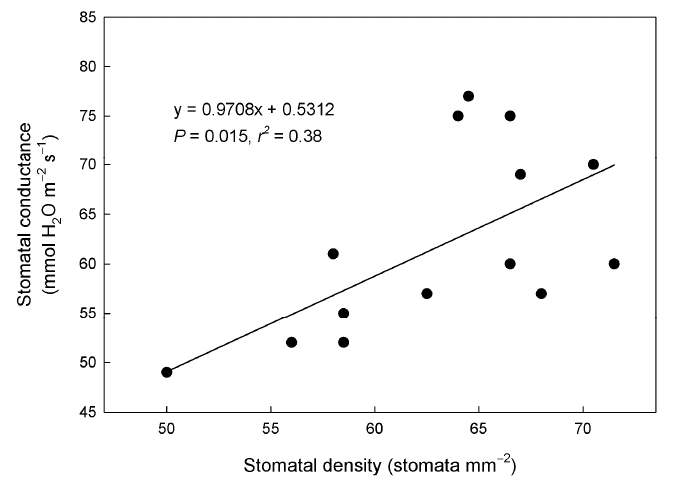
Figure 9. Relationship between the stomatal conductance and stomatal density of Ocimum basilicum . Plants were grown under five different combinations of red, green, and blue LEDs with the same light intensity for 14 days. The regression line was fitted through the data of all the treatments.